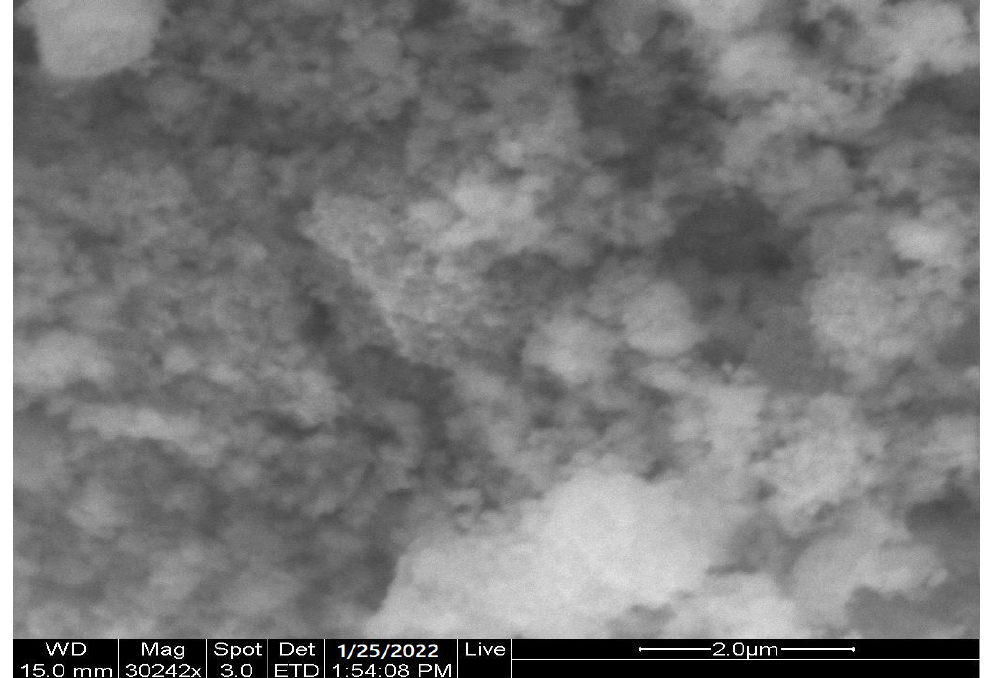
Figure 5. SEM image of CCsMFO nanocomposite.